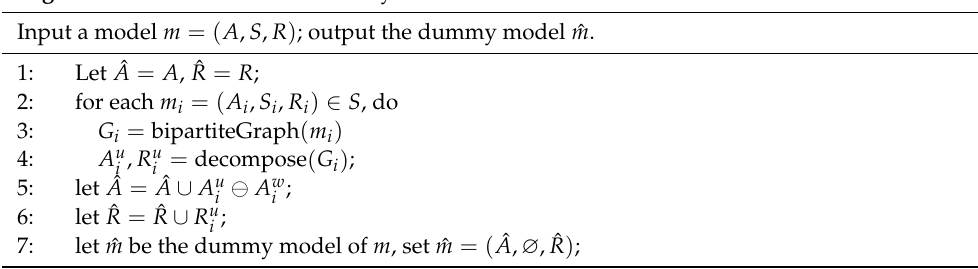
Algorithm 4. Construction of dummy model ˆ